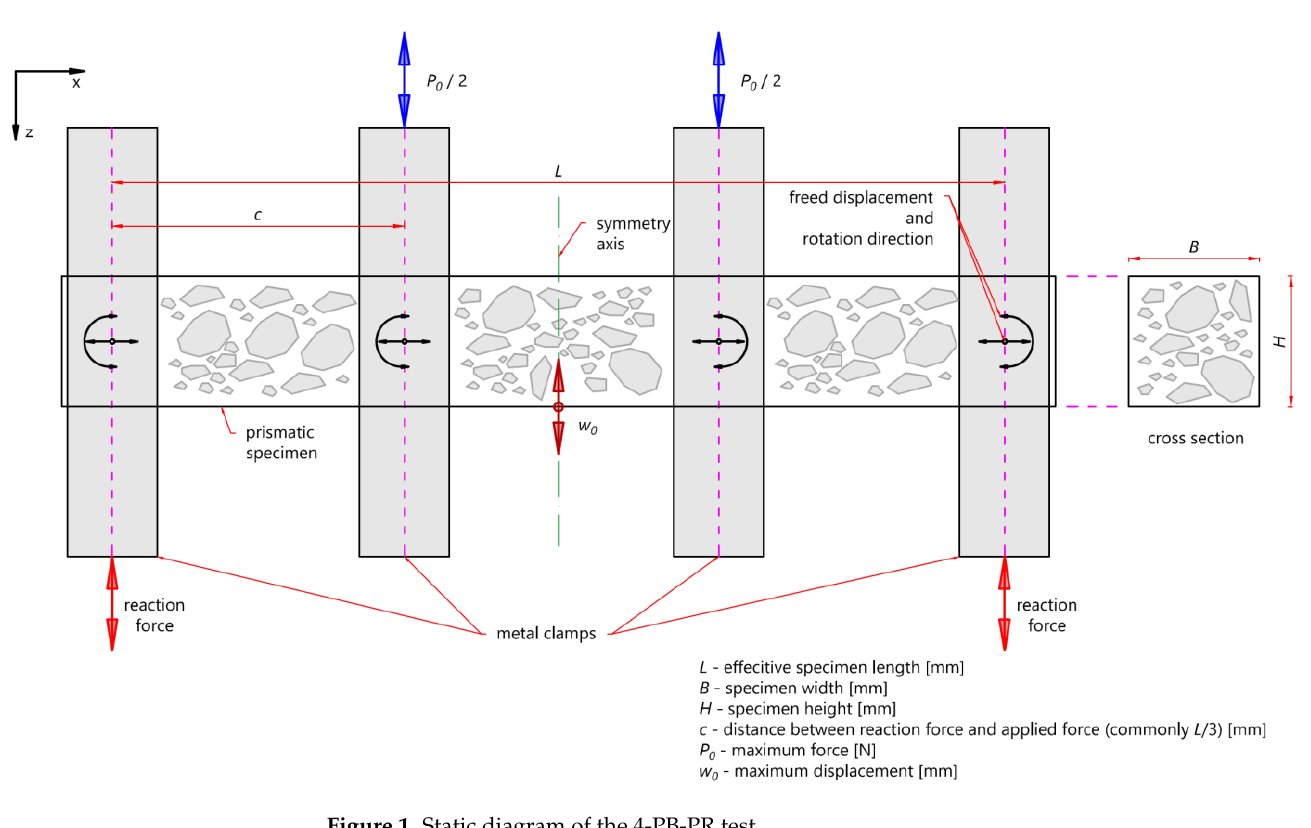
Figure 1. Static diagram of the 4-PB-PR test. Table 2. General fatigue test